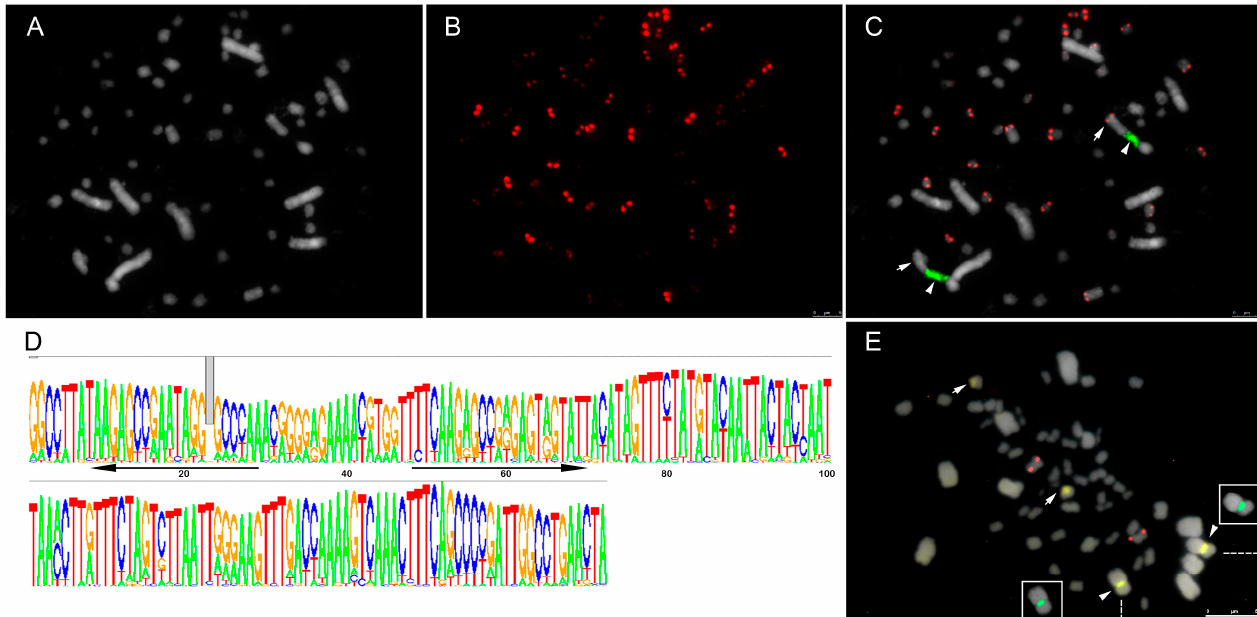
Figure 2. Distribution of tandem repeats and heterochromatin on chromosomes of Agave hybrid H11648. ( A ) DAPI (in grey); ( B ) AgSAT171 probe (in red) showing strong or weak signals in all chromosomes; ( C ) overlay of AgSAT171 (red) and 35S rDNA site (green, arrowheads) showing 20 chromosomes with stronger signals and heteromorphism for the chromosome pair bearing the rDNA site; ( D ) consensus sequence logo of AgSAT171 (black arrows signalized the primer positions); ( E ) CMA + /DAPI − heterochromatic bands (yellow); 5S (red) and 35S ribosomal DNA (in green, insets), with the 35S colocalizing with CMA + bands (arrowheads). Arrows indicate the difference in